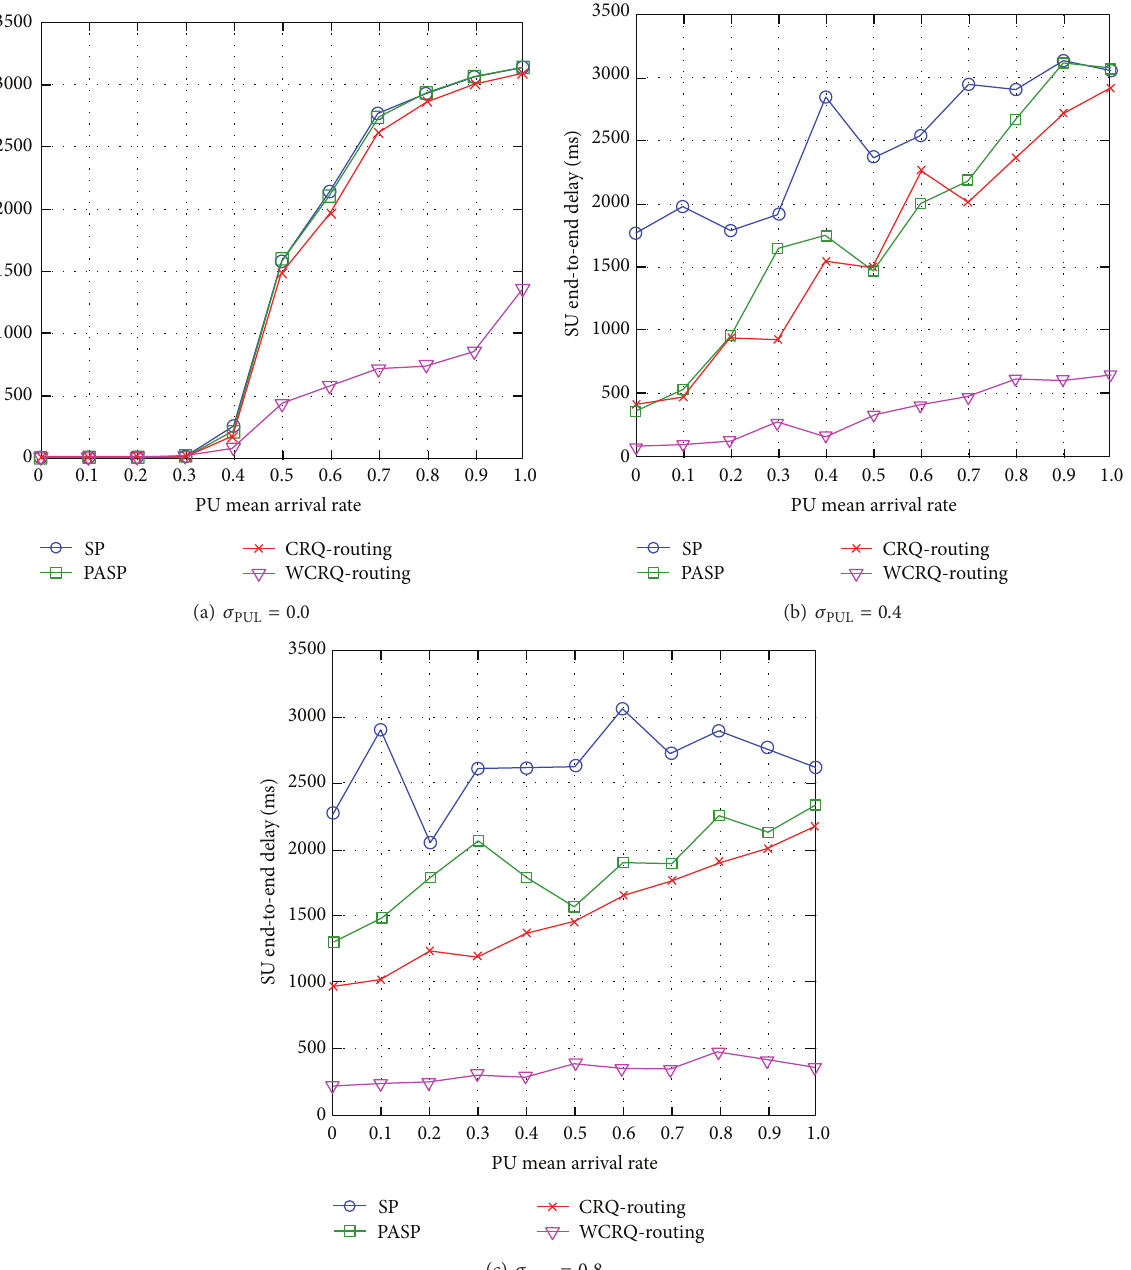
Figure 3: SU end-to-end delay for varying PU mean arrival rate 𝜇